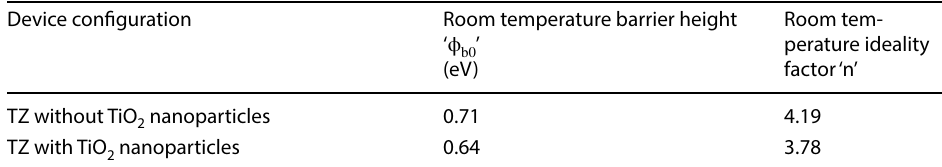
nanoparticles, b with TiO 2